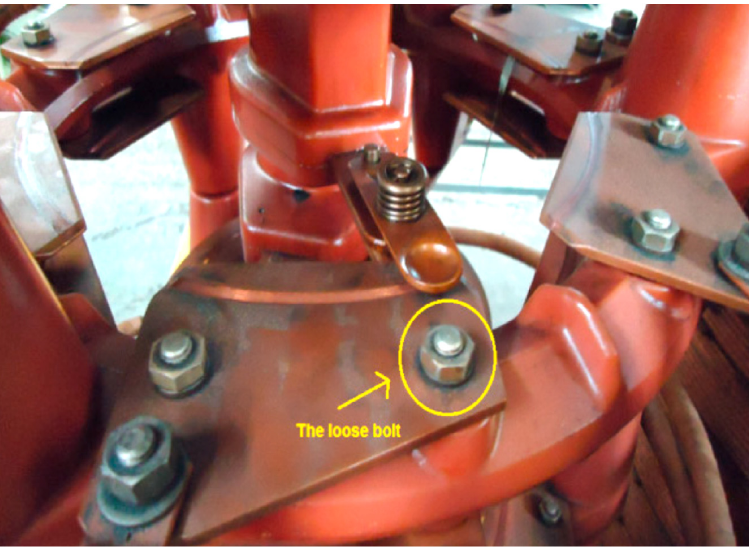
Figure 14. A loose bolt on the selector contact at tap position 9 [51].